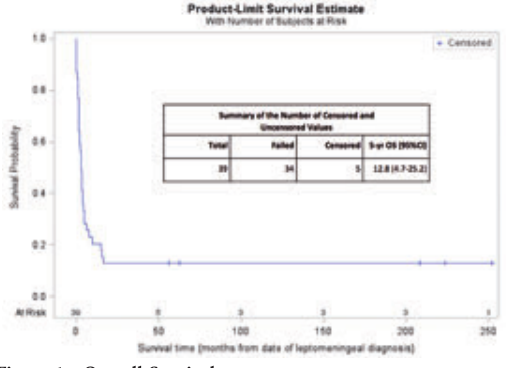
Figura 1 - Overall Survival.